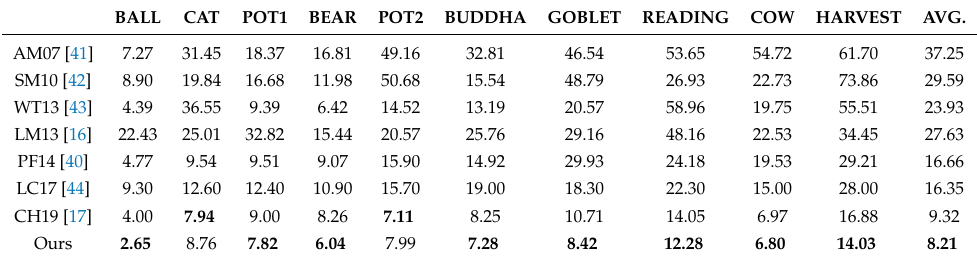
Figure 11. The surface normal estimation results of CH19 [17] and the proposed self-calibrating photometric stereo framework. Rows 1 and 3 are estimated normal maps. Rows 2 and 4 are error maps with the ground truth. The images on the left of each object are the results of CH19 [17], and those on the right are the results of the proposed method. Table 3. The normal errors for 10 objects from the DiLiGenT dataset. The numbers represent the MAE ( ◦